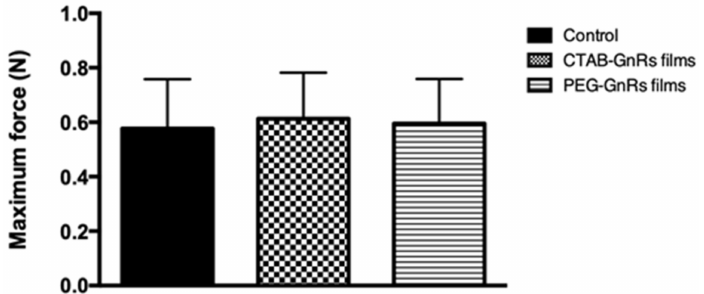
Figure 6. Adhesion studies of polymeric films in neonate porcine skin, where the maximum detachment force was recorded (mean ± SD, n =